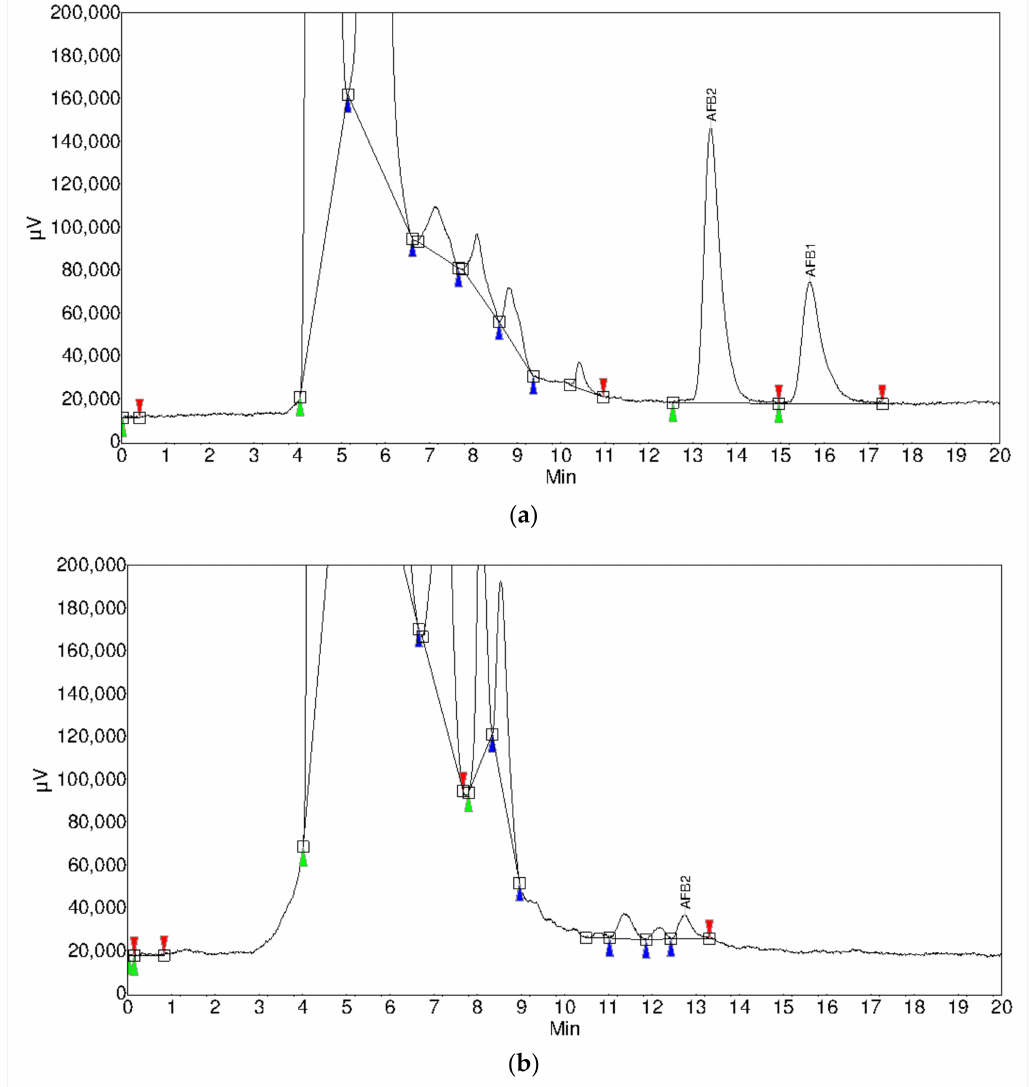
Figure 2. Chromatograms showing the content of aflatoxins B1 and B2 in ( a ) control red wine and ( b ) after treatment with 120 g / hL of